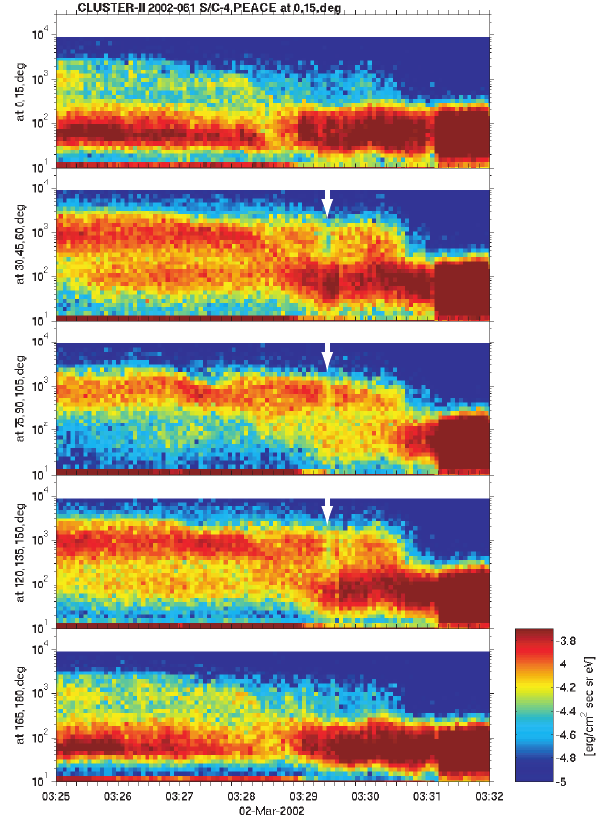
Fig. 9. Electron flux versus time and energy for C4. The sudden decrease in the flux of high energy (400eV) particles (indicated by arrows) coincides with the most intense